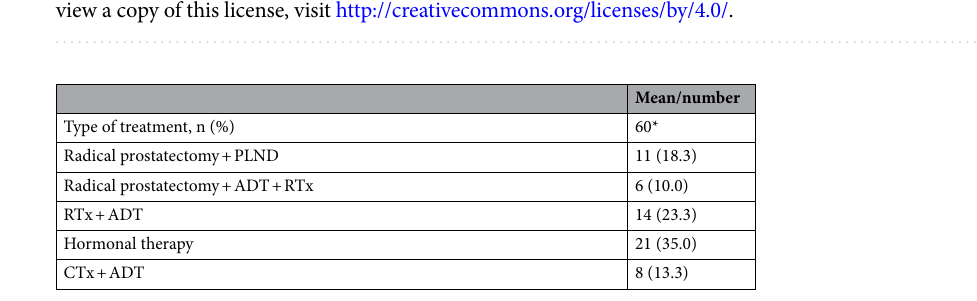
Table 3. Treatment course of the patients (n = 60). PLND, pelvic lymph node dissection; ADT, androgen deprivation therapy; RTx, radiation therapy; CTx, chemotherapy (docetaxel). *Among the 66 patients, there were three follow-up losses, one case of small-cell carcinoma, one case of lymphoma, and one case of a negative biopsy result.